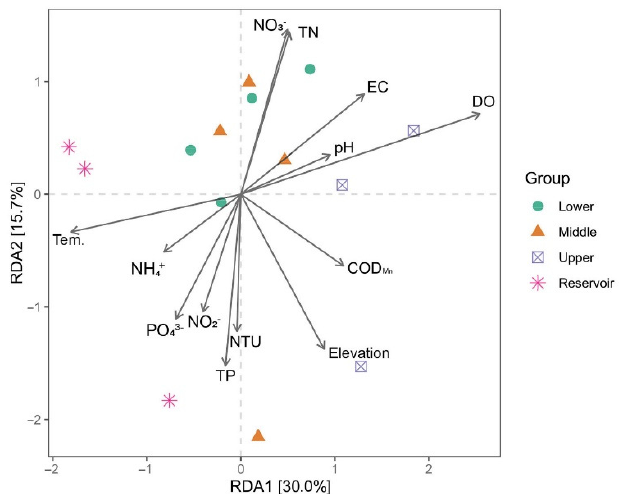
Figure 8. Canonical correspondence analysis (CCA) plots of bacterial communities in the water.